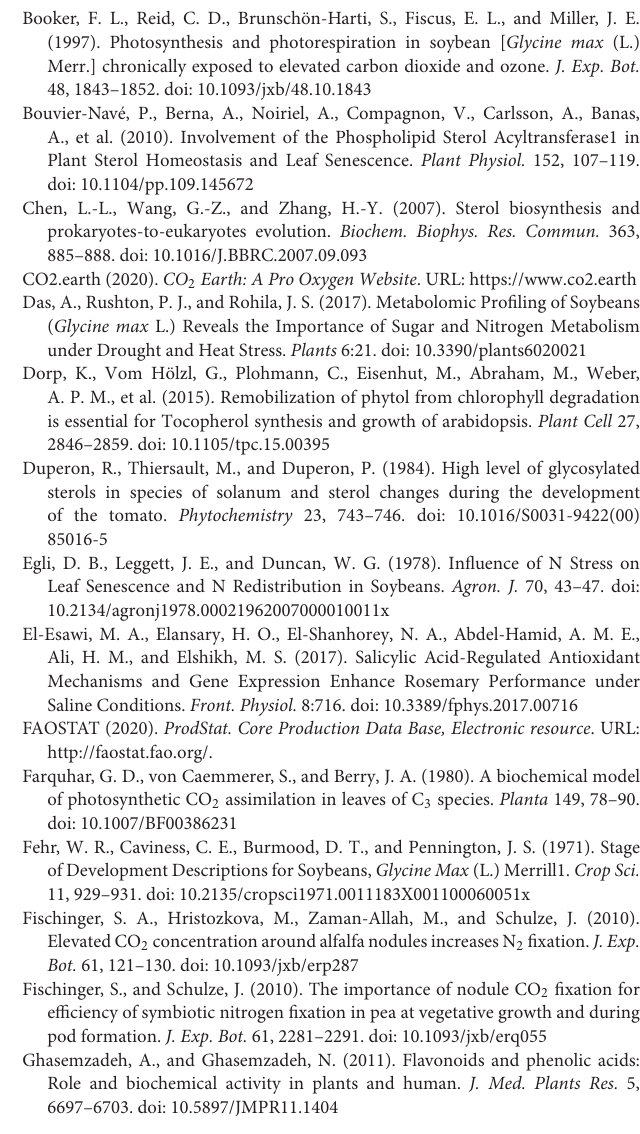
Supplementary Figure 1 | Classification of metabolites detected by GC-TOF/MS-based analysis in leaves and nodules of plants inoculated with USDA110, SFJ4-24, and SFJ14-36 B. japonicum strains under ambient and elevated [CO 2